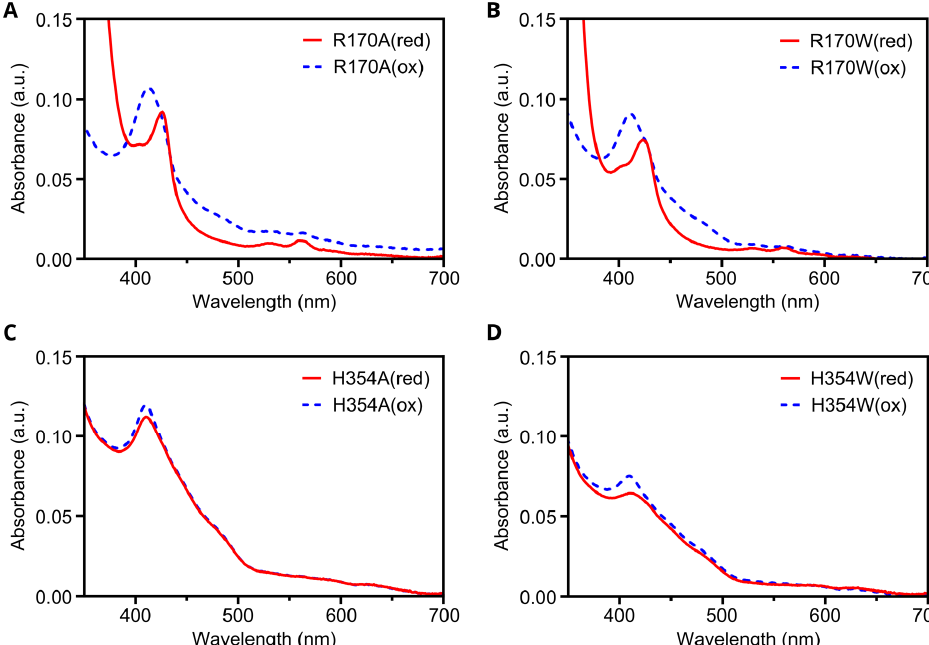
Figure 7. Oxidized and reduced spectra of maize Z-ISO mutants. MBP- Zm Z-ISO Arg170Ala ( A ), Arg170Trp ( B ), His354Ala ( C ), and His354Trp ( D ) proteins produced in E. coli were solubilized in β -DDM and partially purified by amylose affinity chromatography. The oxidized (ox—dotted blue trace) and reduced (red—solid red trace) absorbance spectra of the eluates were measured after addition of potassium ferricyanide or sodium dithionite,